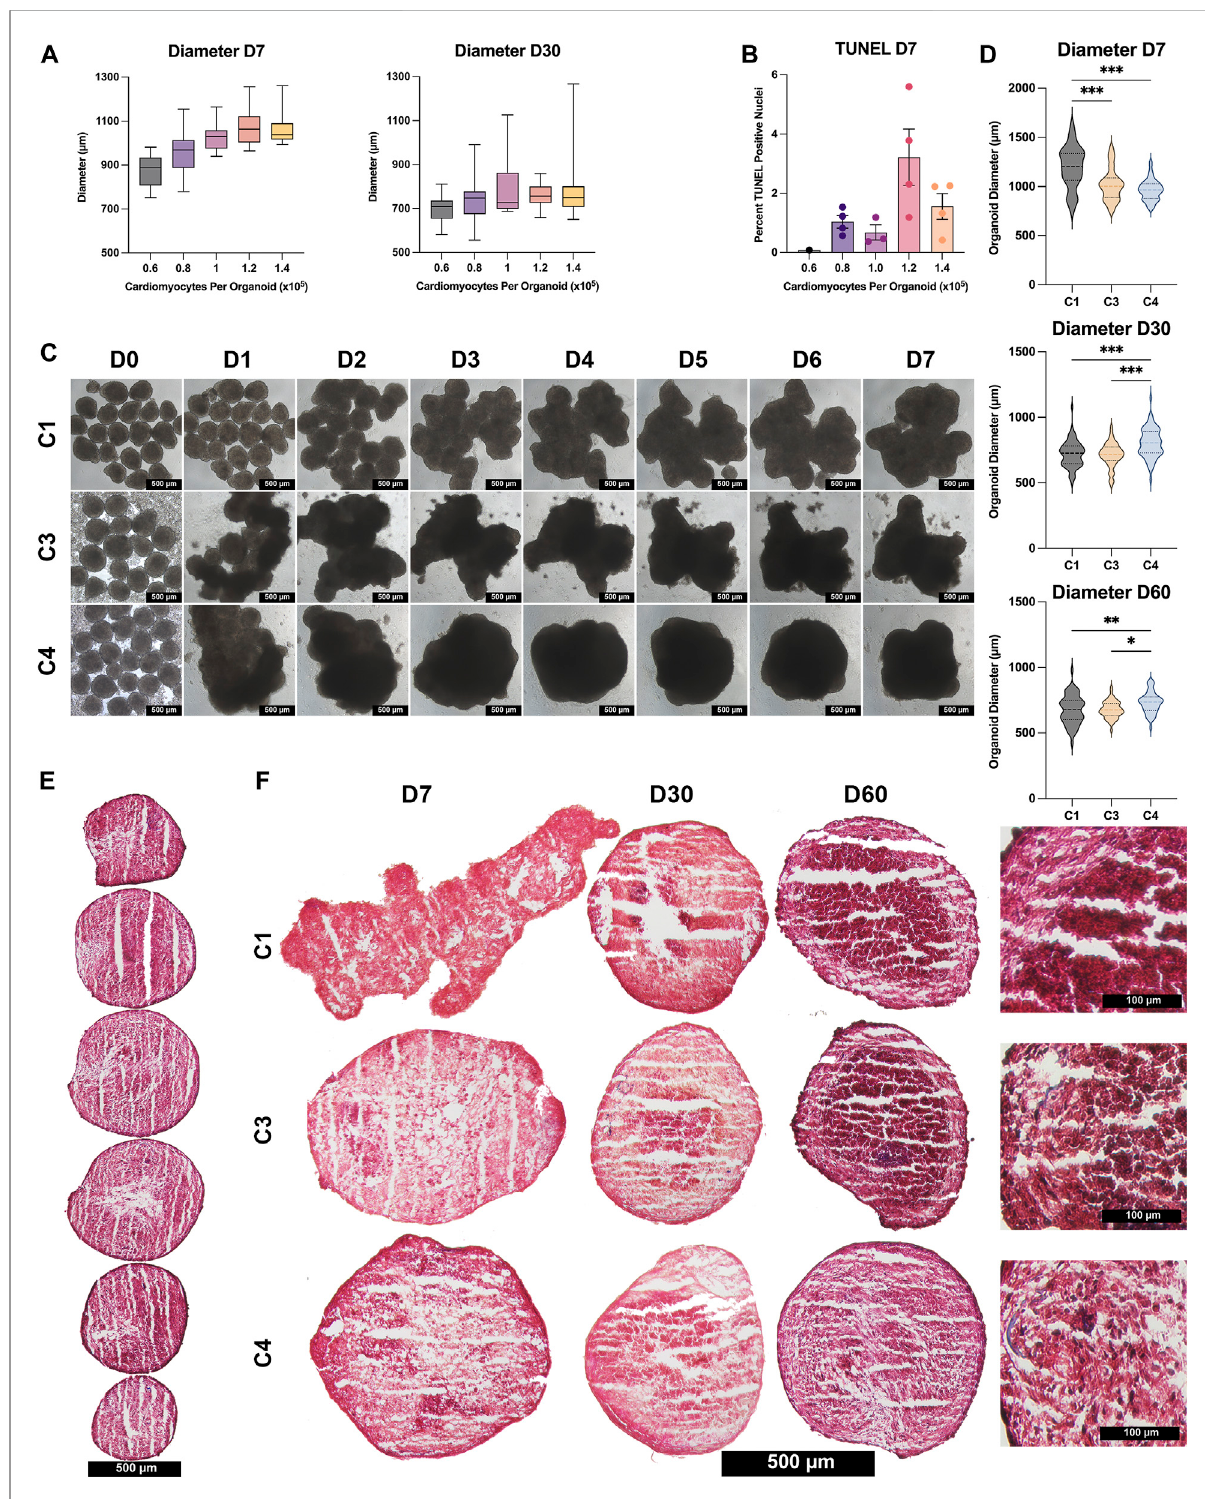
FIGURE 2 Size and histological assessments. (A) C4 spheroids were generated from the indicated CM population sizes (0.6 × 10 5 black; 0.8 × 10 5 purple; 1.0 × 10 5 pink; , 1.2 × 10 5 orange; , 1.4 × 10 5 yellow), and spheroid diameters were measured on D7 and D30; results were displayed as box-whisker plots. (B) C4spheroidswerecutinto10- μ msections,andthesectionswerestainedviaterminaldeoxynucleotidyltransferasedUTPnickendlabeling (TUNEL);then,apoptosiswasquanti fi edasthepercentageofTUNEL-positivecellsin4spheroids/group. (C)